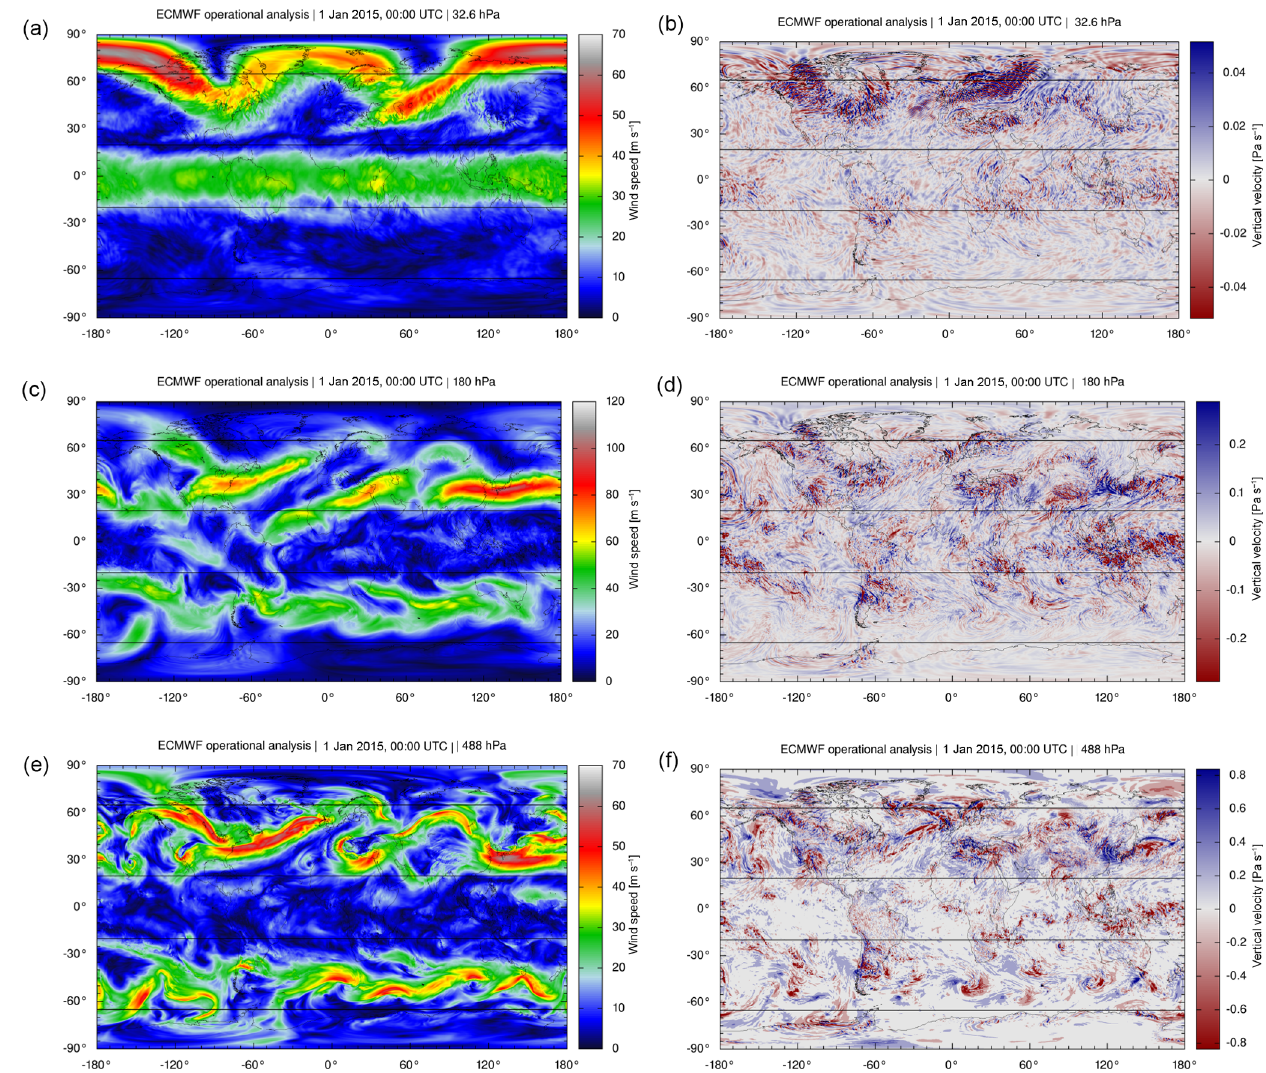
Figure 1. ECMWF operational analysis horizontal wind speed (a, c, e) and vertical velocity (b, d, f) at about 24km (a, b) , 12km (c, d) , and 5km (e, f) altitude on 1 January 2015 (00:00UTC). Black lines indicate the latitude bands considered in our analysis. Note that color bar ranges have been adjusted for each height level to make local structures